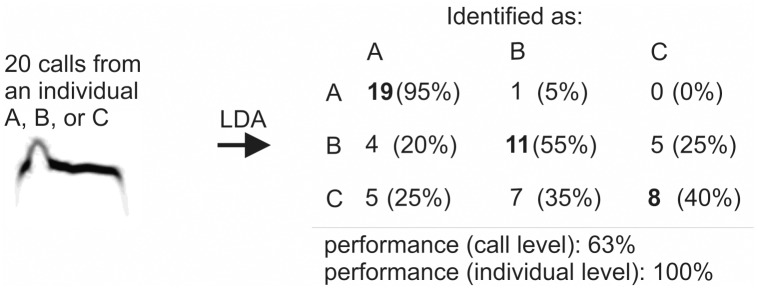
Relationship between the discrimination performance at the call and at the individual level.In this hypothetical example, calling bouts of 20 calls each from individuals A, B, and C are attributed to three individuals by linear discriminant analysis (LDA). Rows represent to which individual calls belonged to and collumns represent to which individual calls were assigned to by LDA. Diagonal represents calls that were attributed to correct individuals. There is 100% discrimination success at the individual level because all three call sets were assigned to correct individual based on majority criterion. Even for C, the set of 20 calls would be correctly identified as belonging to individual C as majority of the calls (40%) were assigned to C. On the other hand, discrimination performance at the call level would be only 63% (overall percentage of correctly assigned calls).